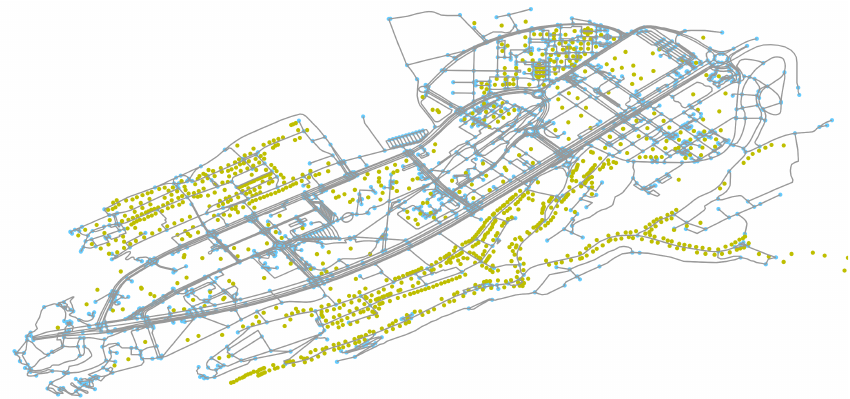
Figure 6. LU2 instance. Blue nodes represent possible locations for carsharing stations. Yellow nodes represent residential